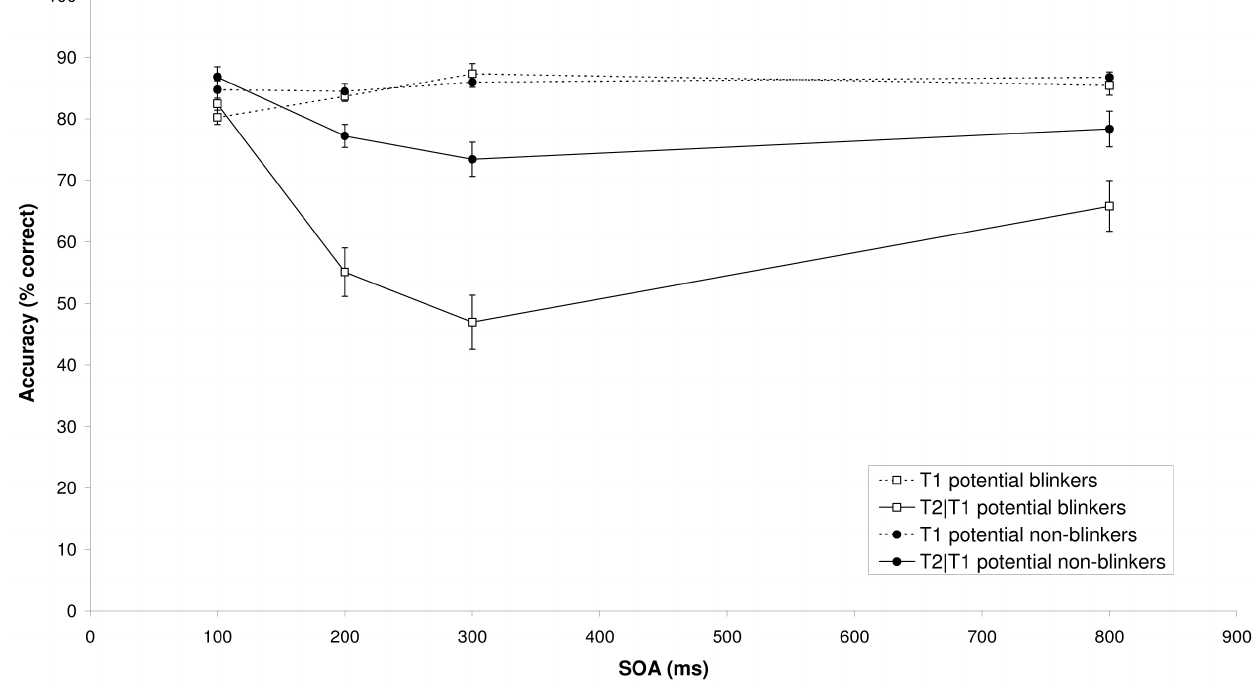
Figure 1. Target accuracy in Experiment 1A. Mean percentage correct report of T1 (dotted lines) and T2 given correct report of T1 (solid lines) as a function of SOA for candidate blinkers (square symbols) and non-blinkers (circle symbols) in the alphanumeric AB task of Experiment 1A.